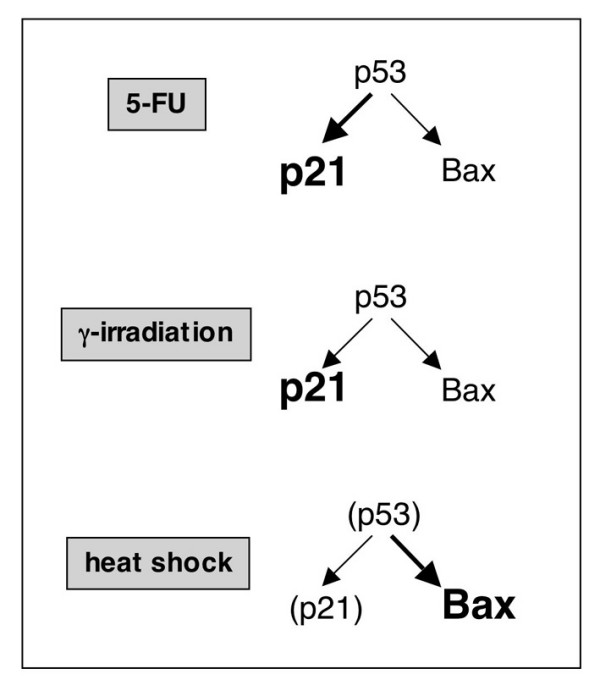
Model of individual genes (p53, p21CIP/WAF-1 and Bax) showing differential impact on the cell death induction by 5-FU, IR or heat shock.